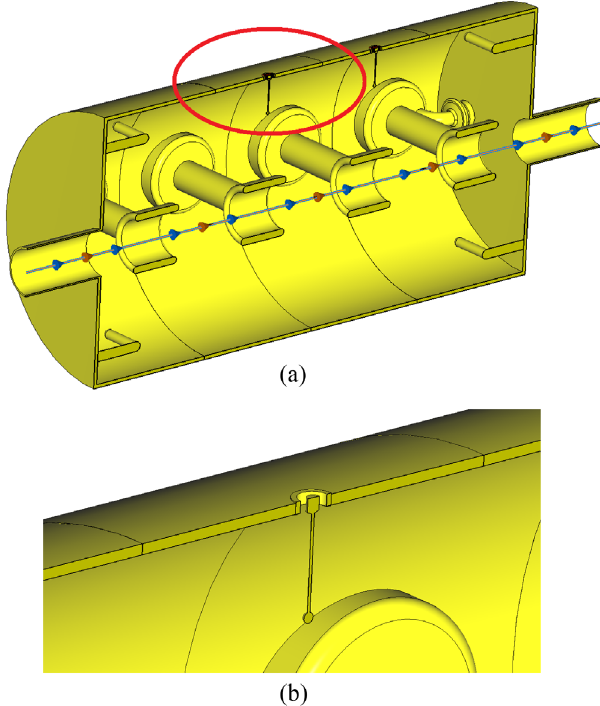
FIG. 2. (a) A simplified, four-cell SPS TW cavity used to compare the proposed scheme with direct computations. (b) Mag- nification of the red-marked region in (a) showing a probe-type HOM coupler which is terminated with various termination impedances Z . The geometry is kindly provided by [37]. ter ;m